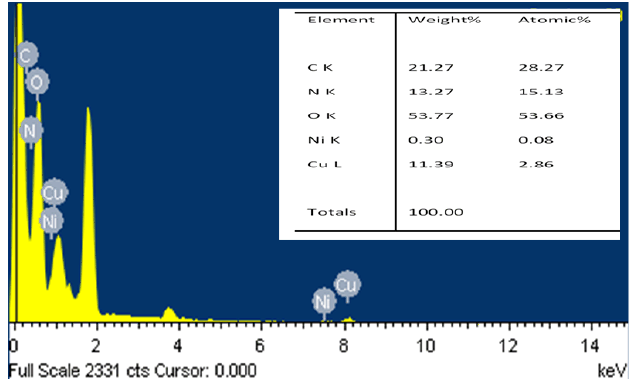
Figure 3. EDX compositional analysis of organic-inorganic composite film.